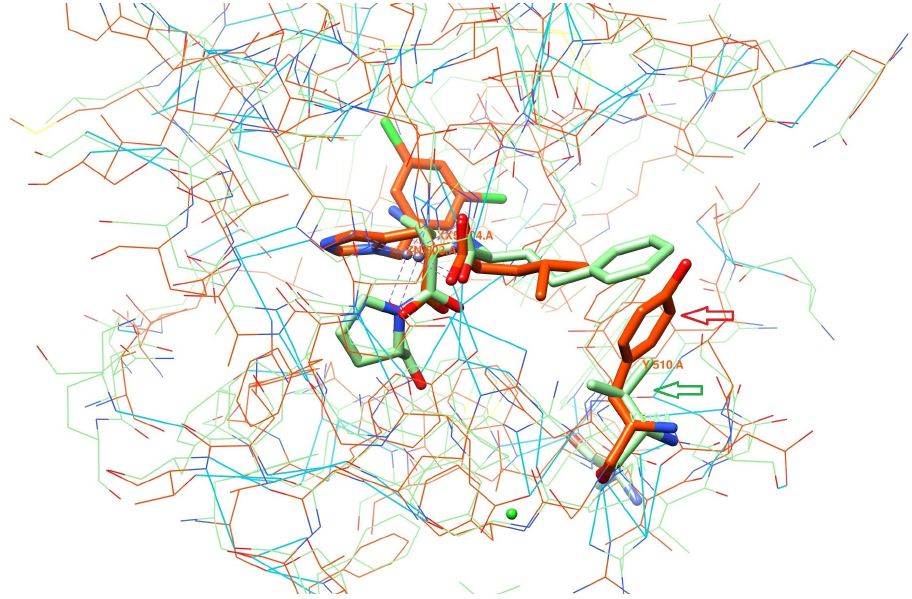
Figure 1. Comparison of ACE2 and ACE binding sites. In lime green—ACE with ligand lisinopril (PDB code: 1O86/LPR ), in orange—ACE2 with ligand ORE-1001 (PDB code: 1R4L/XX5 ), in blue— hydrogen-bonding contacts. Lime green and orange arrows are pointing at VAL518 and TYR510 in ACE and ACE2, respectively.